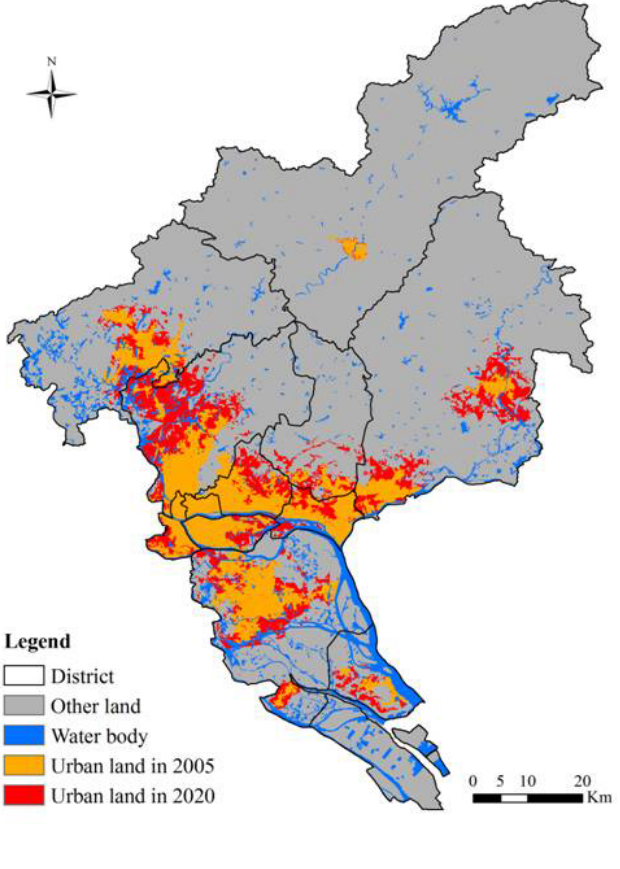
Fig. 5 . The simulation of Guangzhou metropolitan region in 2020 for rapid development scenario.